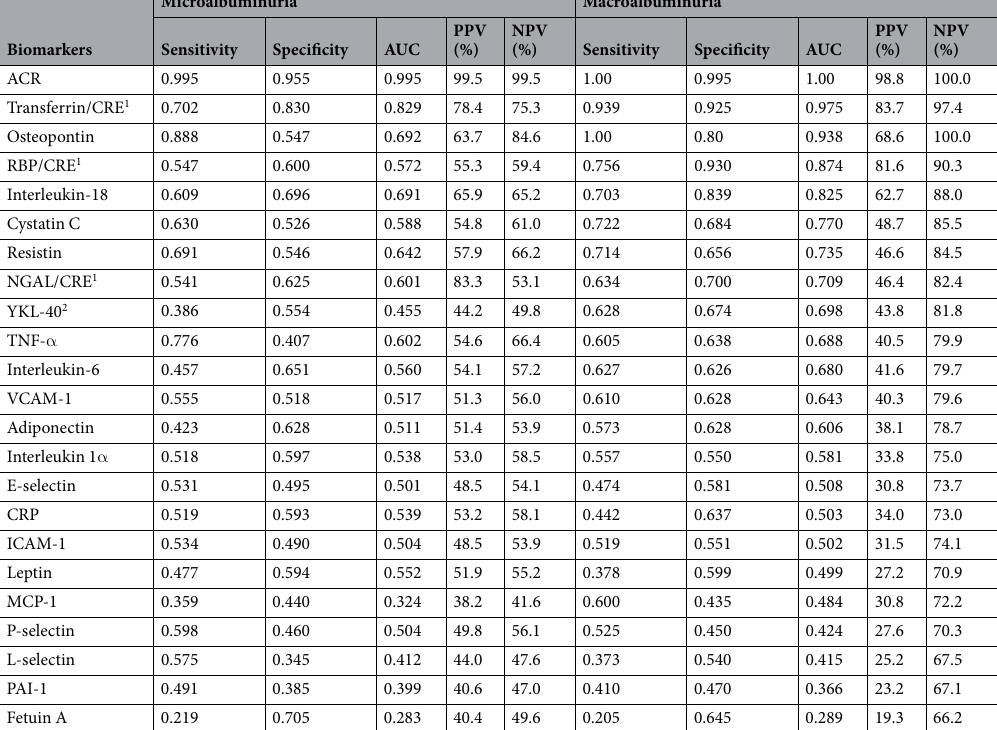
Table 3. Sensitivity, specificity and AUC for the 22 markers in detecting cases with microalbuminuria or macroalbuminuria. All biomarkers were analyzed using blood serum, except for 2 YKL-40 which was plasma in origin and 1 transferrin, 1 RBP, and 1 NGAL which were urine samples presented as markers to creatinine ratio. PPV: positive predictive value; NPV: negative predictive value. Area under the curve was classified according to the following: excellent (1.0-0.9); very good (0.9-0.8); good (0.8-0.7); sufficient (0.7-0.6) and bad or not useful ( <